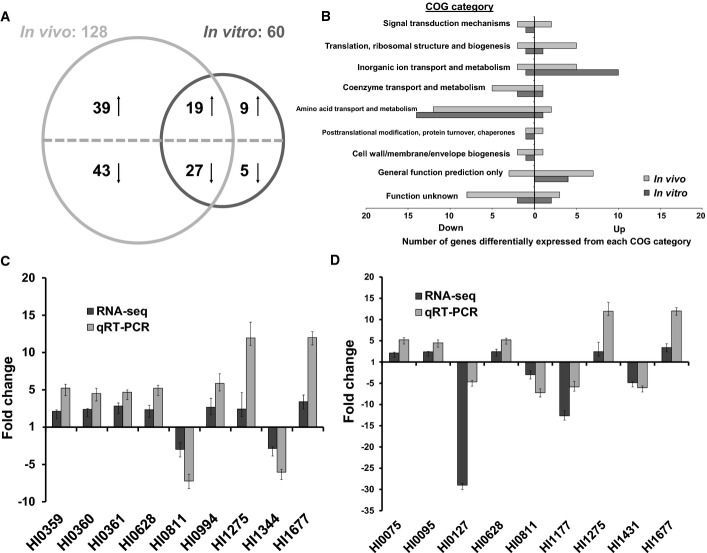
H. influenzae genes differentially regulated during growth in complex media and during lung infection in the presence of corticosteroids
A Venn diagram showing the overlap of H. influenzae genes whose expression is up-regulated or down-regulated by the presence of corticosteroids in sBHI medium (in vitro) or in the mouse model of infection (in vivo). Genes that are divergently regulated in these conditions are not depicted in this Venn diagram but can be found in the complete RNA-Seq dataset detailed in Supplementary Table S2.

B COG map detailing significantly enriched or scarce functional categories expressed in vitro and in vivo during the presence of corticosteroids.

C, D Comparison of relative fold changes between RNA-seq and qRT–PCR results in vitro (C) and in vivo (D) in the presence of corticosteroids. All qRT–PCR results were normalized using the Cts obtained for the 16S rRNA amplifications run in the same plate. The relative levels of gene transcripts are determined from standard curves. Values given are the mean and standard deviation of triplicate measurements (three biological and three technical replicates).